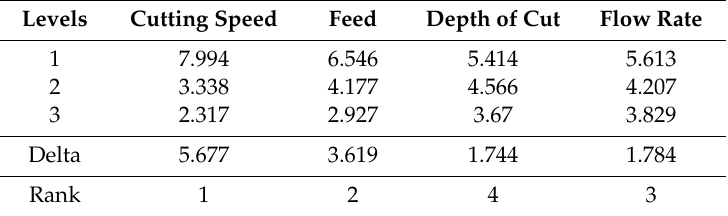
Table 7. Response table for total machining cost.